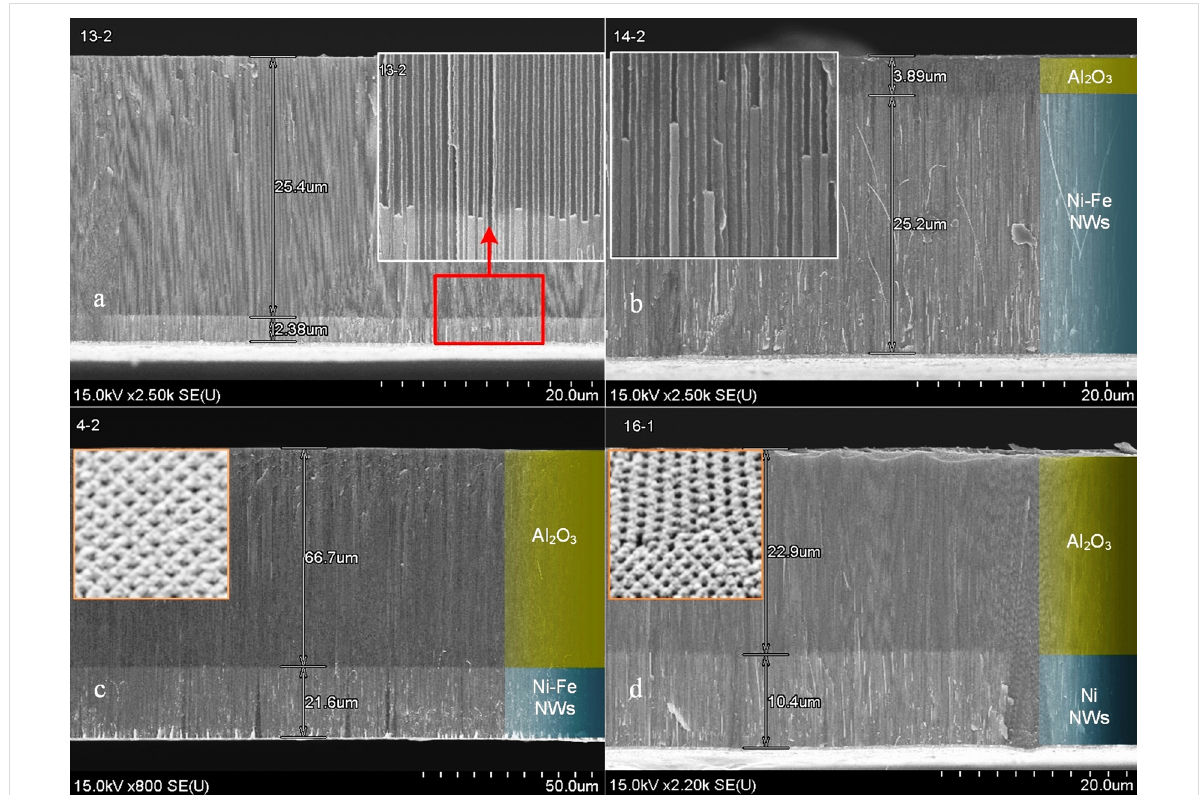
Figure 3: SEM cross-sectional views of the alumina template after galvanostatic dc deposition of Ni–Fe (a, b, c) and Ni (d) NW arrays under the following conditions: current density 3 mA·cm − 2 , deposition duration 10 min (a, d), 90 min (b) and 150 min (c). In the insets: the top-view SEM images of the template (red frame) and the enlarged image of the deposition front depending on deposition duration.